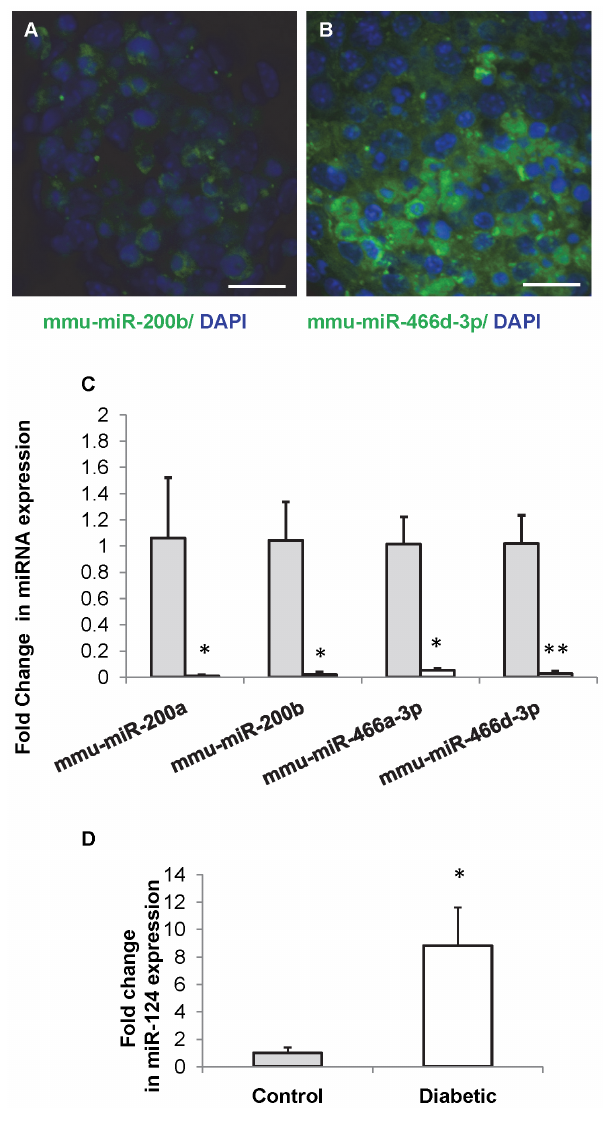
Figure 3. miRNA expression is altered in NSCs from diabetic pregnancy. (A, B) in situ hybridization reveals expression of miRNAs mmu-miR-200b (A) and mmu-miR-466d-3p (B) in NSCs. The nucleus is counterstained with DAPI (blue). Scale bar: 50 m m. (C) miRNA expression analysis revealed decreased expression of miRNAs mmu- miR-200a, mmu-miR-200b, mmu-miR-466a-3p and mmu-miR-466d-3p in NSCs from diabetic pregnancy (open bars) when compared to the control (filled bars). Mean 6 SD (n=4), *p , 0.05, **p , 0.01 (D) Expression of neuron specific miRNA, miR-124 was significantly increased in NSCs from diabetic pregnancy (open bars) when compared to the control (filled bars). Data is represented as mean 6 SD from three independent experiments, *p ,